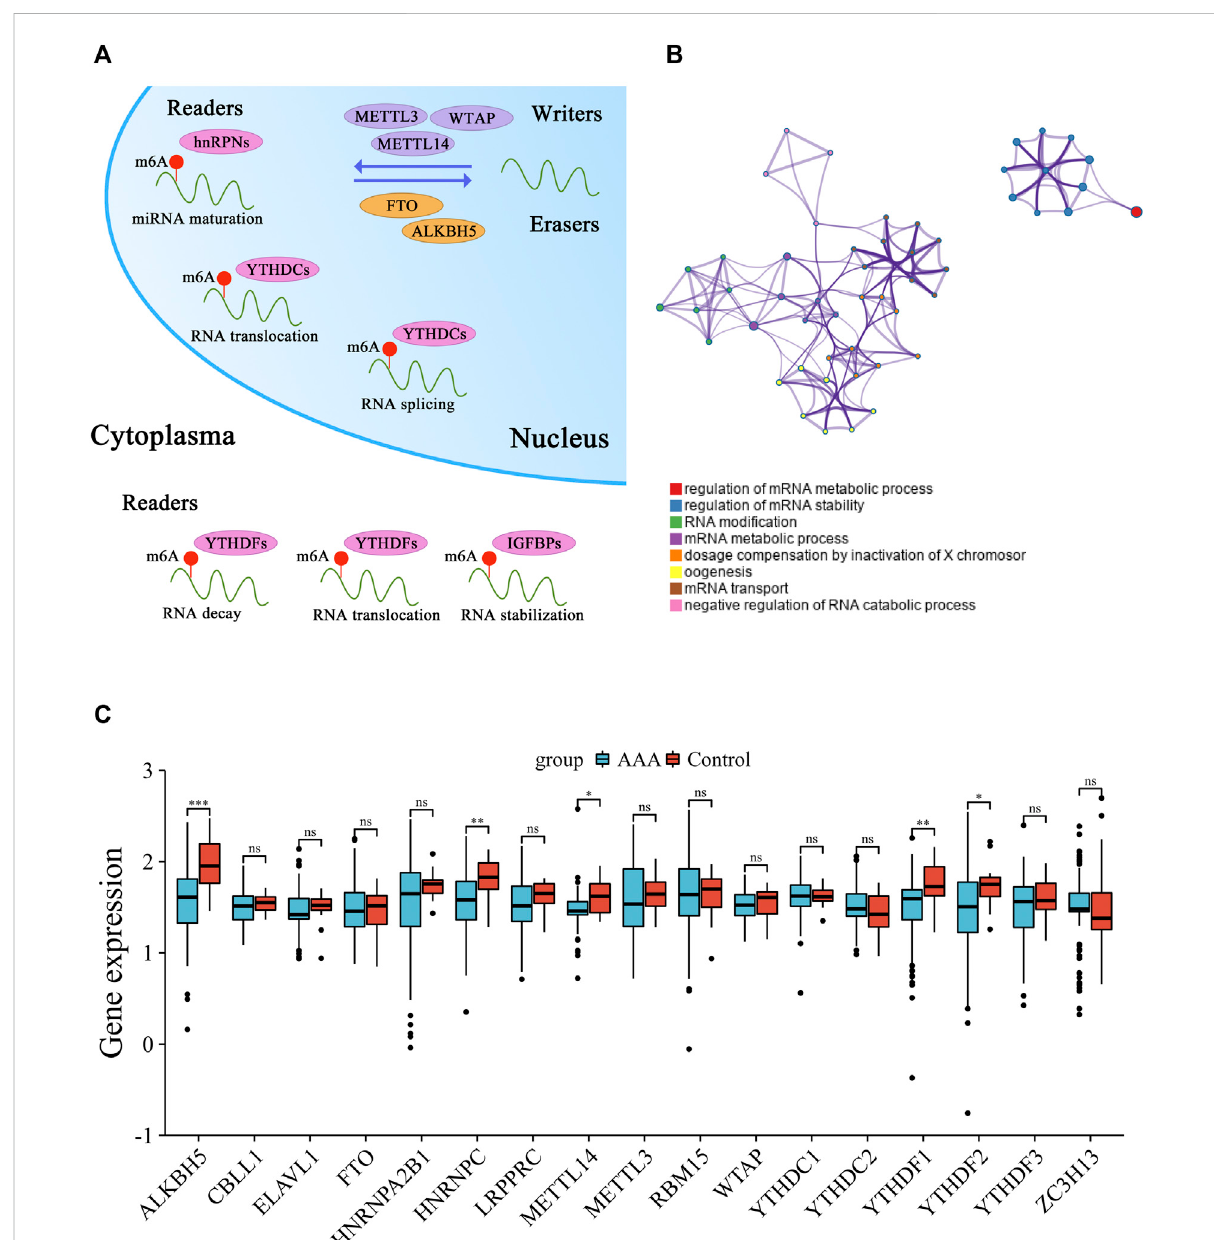
FIGURE 1 Transcriptional alterations of 17 m6A methylation regulators in AAA. (A) The schematic diagram of dynamic and reversible process of m6A RNA methylation. (B) The biological process annotations of 17 m6A methylation regulators analyzed by Metascape website tool. (C) Boxplot of the discrepant expression of m6A methylation regulators between AAA and control artery samples. AAA: blue; Control: red. (ns: no signi fi cance, * p < 0.05, ** p < 0.01, *** p <